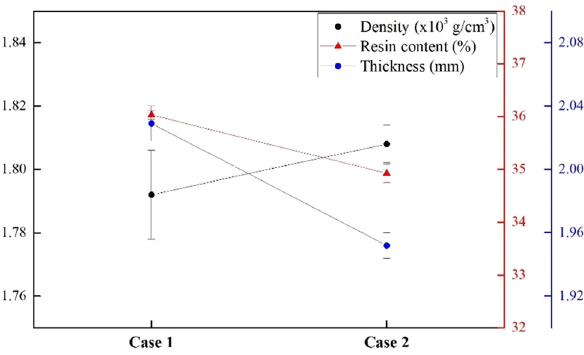
Figure 7: Specimen density, resin content, and thickness according to the process.